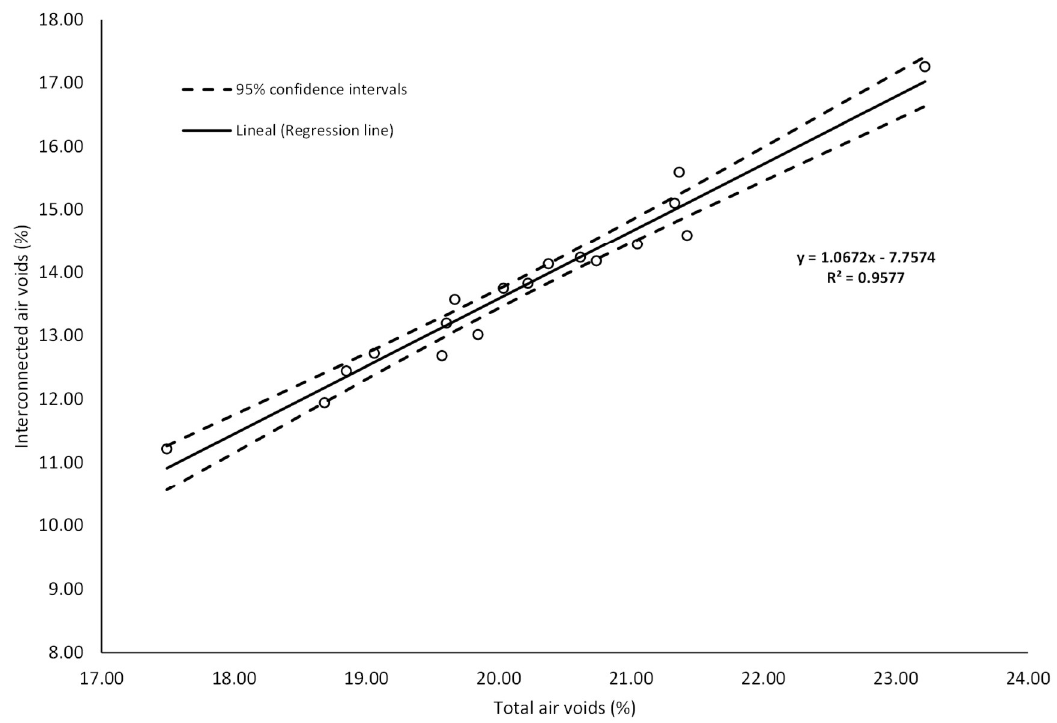
Figure 5. Linear relationship between total and interconnected air voids content.